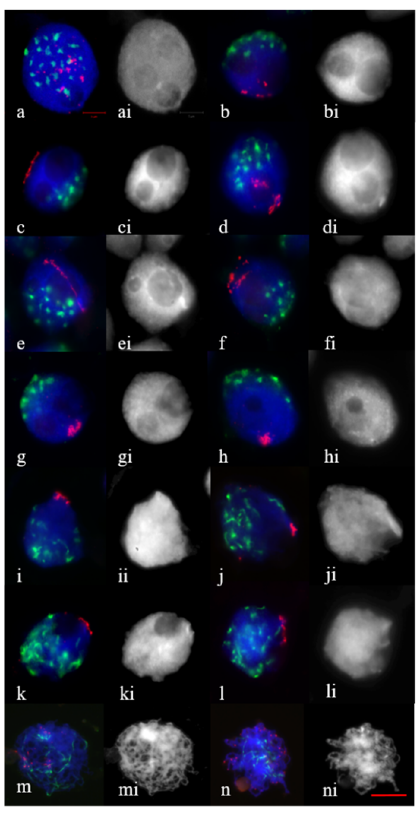
Figure 1. Telomere–centromere dynamics through meiotic prophase in wheat ( a , i ) and wheat–rye disomic substitution lines 1R(1A) ( c , e , g , k , m ), 2R(2D) ( b , d , f , h , j , l , n ). ( a ) Mid–late interphase with 3 nucleoli. ( b – h ) Leptotene with two nucleoli. Early–mid zygotene ( i , j ) with one peripherally located nucleolus. ( k ) Late zygotene, ( l ) early pachytene. ( m ) Pachytene. ( n ) Early diplotene. ( ai – ni ) The same as ( a – n ), DAPI. Telomeres are stained red and centromeres, green. Scale bar = 10 μ m.